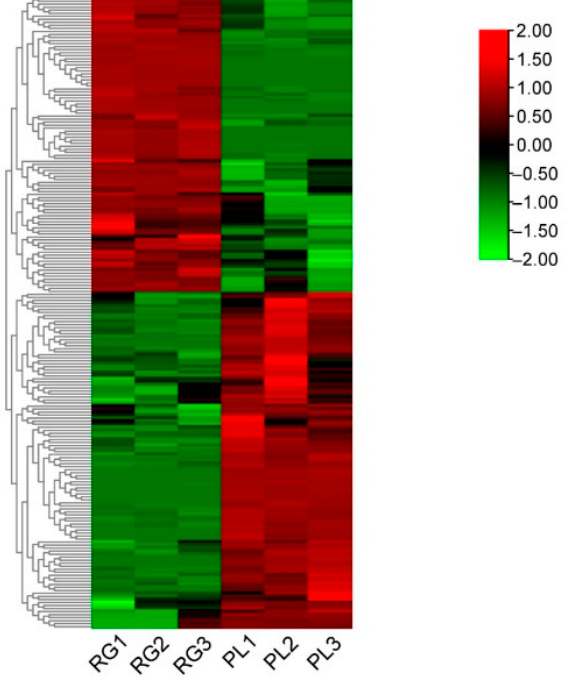
Figure 2. The heat map of the leaf relative levels of each metabolite and the unsupervised hierarchical clustering from independent biological replicates in T. hemsleyanum . The metabolites relative content in low and high are shown in green and red, respectively.